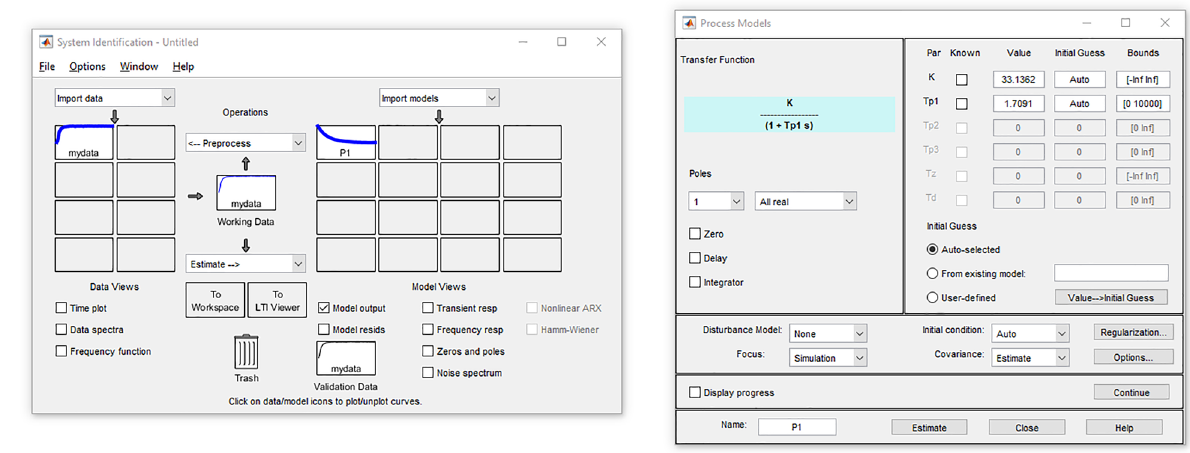
Figure 3. MATLAB system identification toolbox.